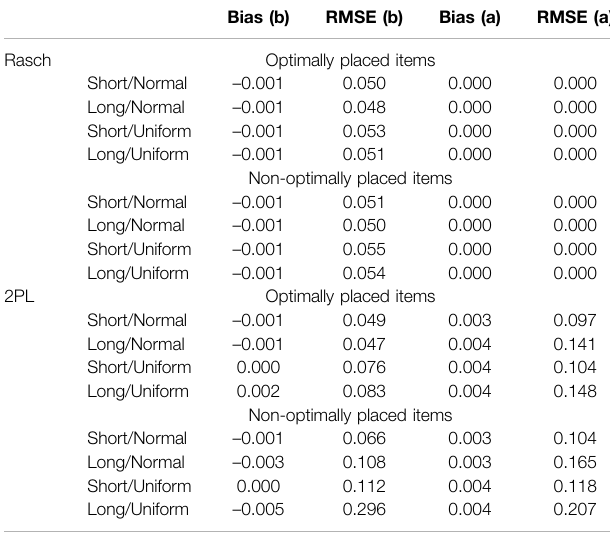
TABLE 3 | Optimally vs. non-optimally placed items